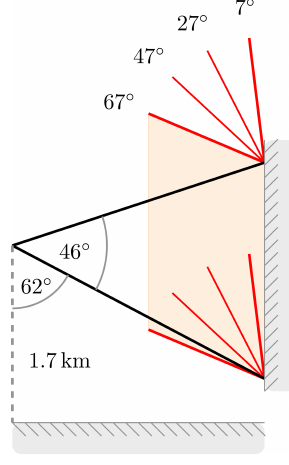
Figure 18. Setup of the viewing geometry ( (cid:49)ϑ = 46 ◦ , starting 62 ◦ from nadir) and the illumination geometry ( ϑ 0 = 7, 27, 47 and 67 ◦ ) for the airborne ( h = 1 . 7km) 3-D forward simulation ensemble. The horizontal extent of the field of view is (cid:49)ϕ = ± 45 ◦ from the principal